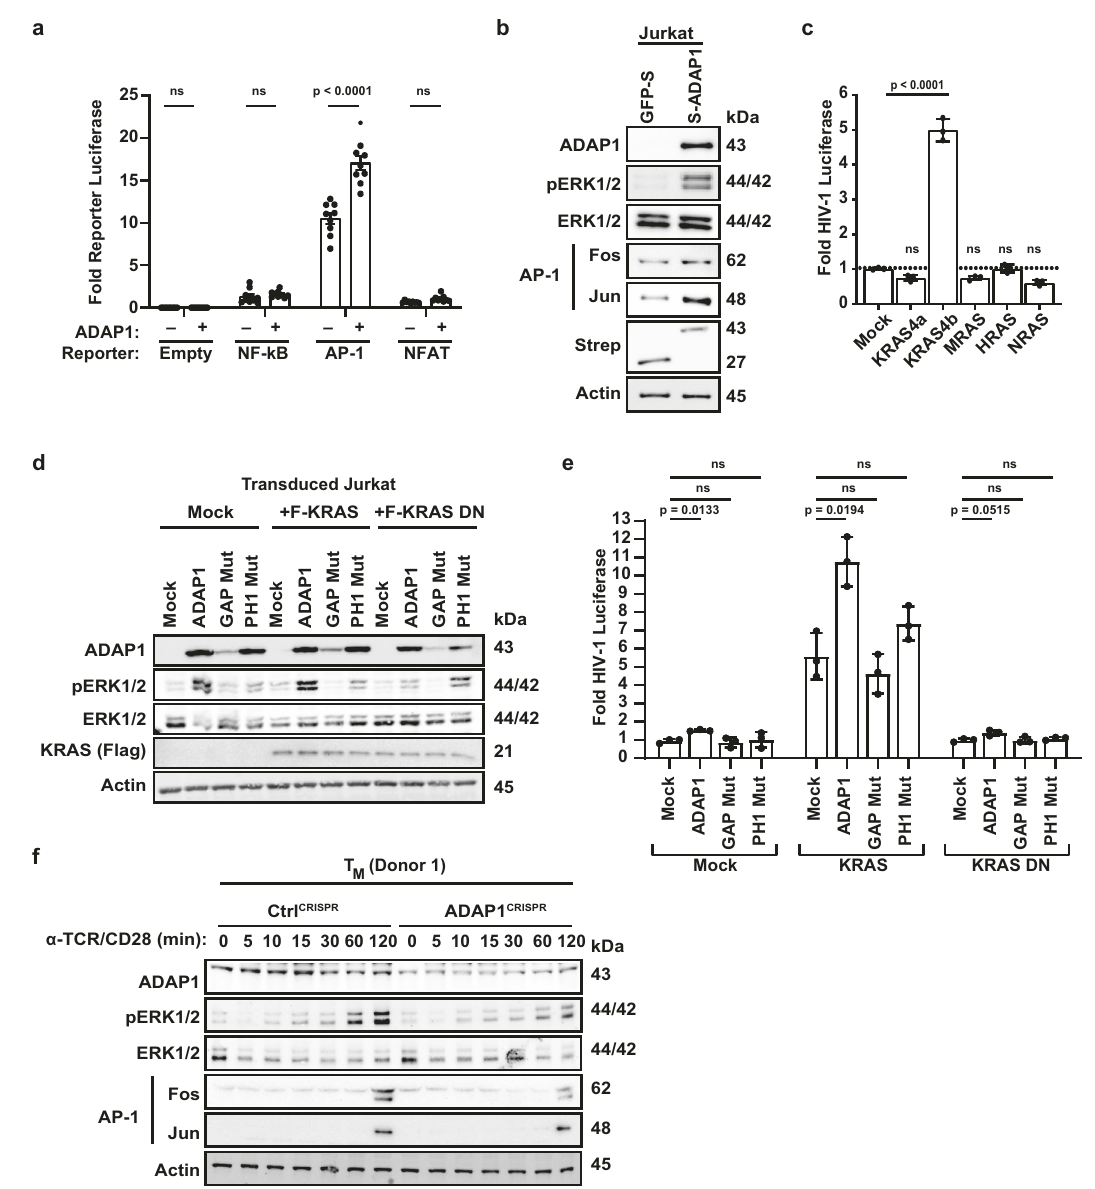
Fig. 6 ADAP1 promotes ERK – AP-1 activation in a KRAS-dependent manner. a Jurkat cell lines expressing Strep-tagged ADAP1 or GFP were electroporated with TF-responsive element driving Fire fl y luciferase reporters. Fire fl y luciferase activity was measured 48 h post electroporation normalized to a CMV-Renilla control. Data represents mean ± s.d. of three independent electroporation experiments in triplicate (two-way ANOVA followed by Sidak ’ s test for multiple comparison between ADAP1 − and ADAP1 + groups). ns not signi fi cant. b Western blot analysis of Jurkat cell lines expressing Strep-tagged ADAP1 or GFP in the absence of stimulation. Blots are representative of three independent experiments. c Fold luciferase activity comparing RAS family members in transduced Jkt-HIVLuc model. Data represents mean ± s.d. fold luciferase activity ( n = 3). (one-way ANOVA followed by Dunnett ’ s test for multiple comparisons to mock). ns not signi fi cant. d Western blot analysis of Jurkat cells co-transduced with ADAP1 (WT, GAP Mut, or PH1 Mut) and limiting amounts of Flag-tagged KRAS (WT or dominant negative S17N). Blots are representative of three independent experiments. e Fold luciferase activity comparing co-expression of ADAP1 (WT, GAP Mut or PH1 Mut) with low level (4:1 lentiviral dilution) KRAS (WT or DN) in transduced Jkt-HIVLuc cells. Data represents mean ± s.d. fold luciferase activity ( n = 3) (two-way ANOVA followed by Dunnett ’ s test for multiple comparison to mock). ns not signi fi cant. f Western blot analysis of primary ADAP1 CRISPR and Ctrl CRISPR T M stimulated with anti-TCR/anti-CD28 beads in a time-course-dependent manner from 0 to 120 min. Blots shown are representative examples from one of four donors. Source data are provided as a Source Data fi